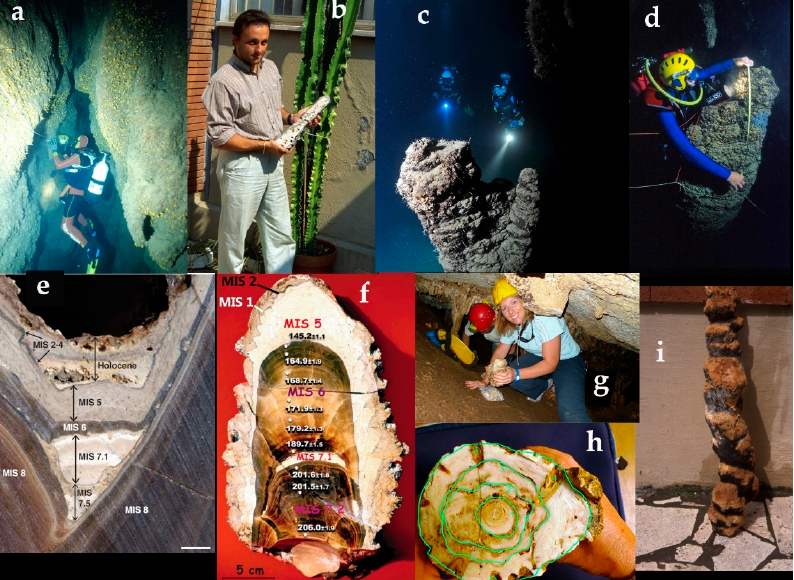
Figure 5. Coastal caves and submerged speleothems from Italy. ( a ): Sampling survey at − 27 m in the Scaletta cave (Palinuro). ( b ) Prof. Marco Oliverio (Sapienza University) carrying the stalagmite collected at − 48 m in the Scale tt a cave (Palinuro). ( c,d ) Argentarola cave and a large stalagmite covered by serpulid overgrowth. ( e ) Stalagmite ASN collected at − 18 m in the Argentarola